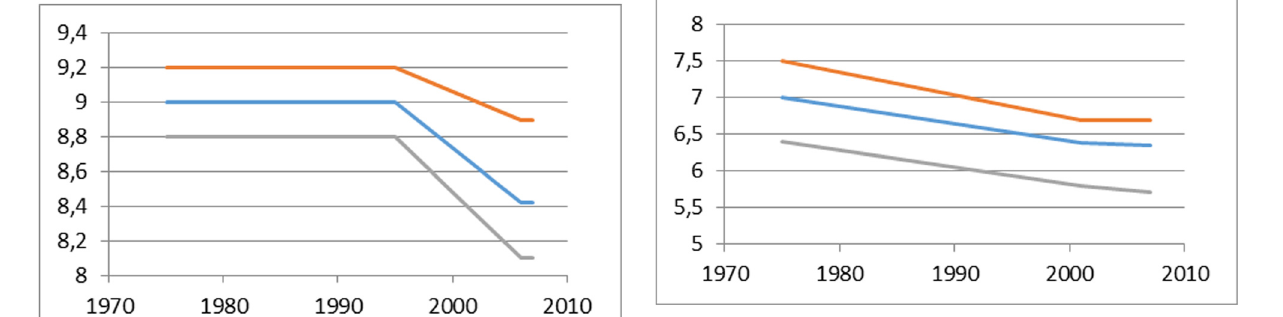
Figure 14: The progress of corrosion during the use of tank number 1 inventoried by the authors for the second coating sheet ( maximum, average, and minimum values are compared here for illustrative purposes ) .